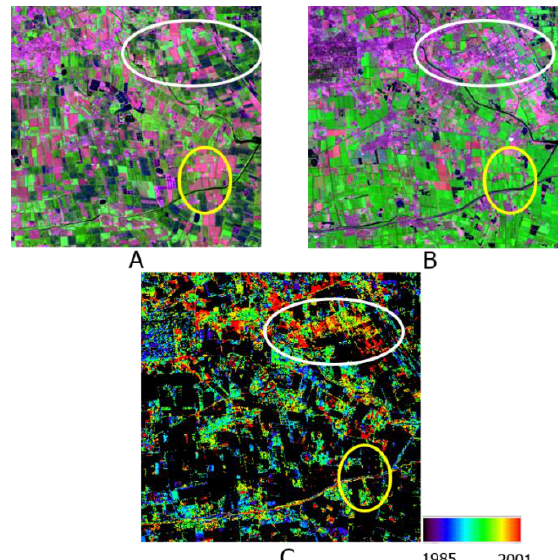
Figure 3. Details of annual urban built-up change area